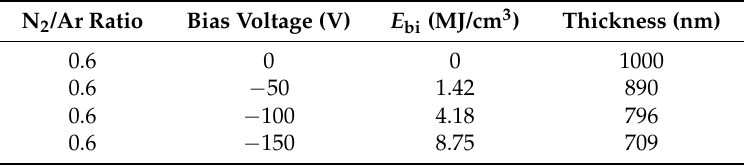
Table 2. The thickness and E bi of NbN coatings as a function of bias